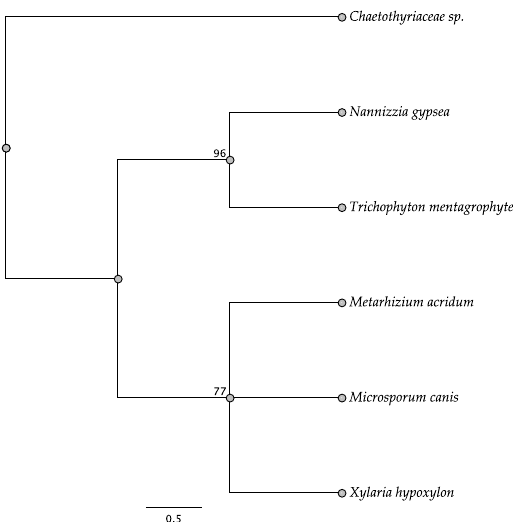
Figure 10. Maximum parsimony DNA tree resulting from the analysis of the swnH2–swnK inter- genic region sequence data. Bootstrap confidence values from 1000 bootstrap replicates are pre- sented at each corresponding node. Fungal orders are indicated next to each organism/clade.